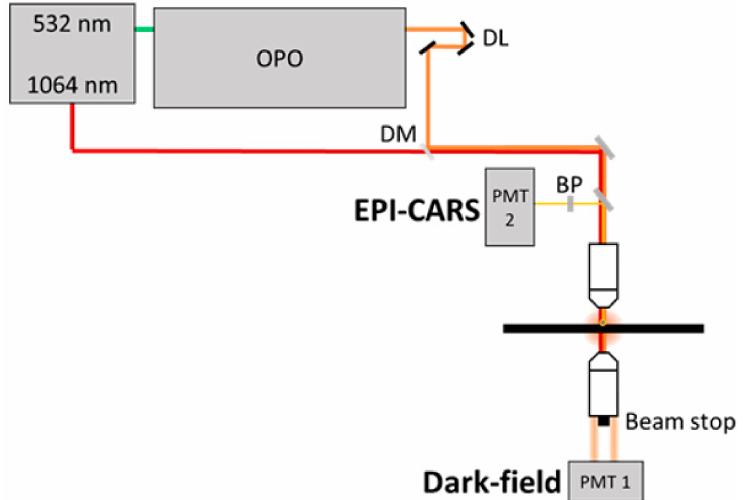
Figure 1. Combined dark field (DF) and coherent ant-stokes Raman (CARS) microscopy setup composed of a laser optical parametric oscillator (OPO) system, delay line (DL), dichroic mirror (DM), objectives, beam stop, bandpass filter (BP), and photomultiplier tube detection